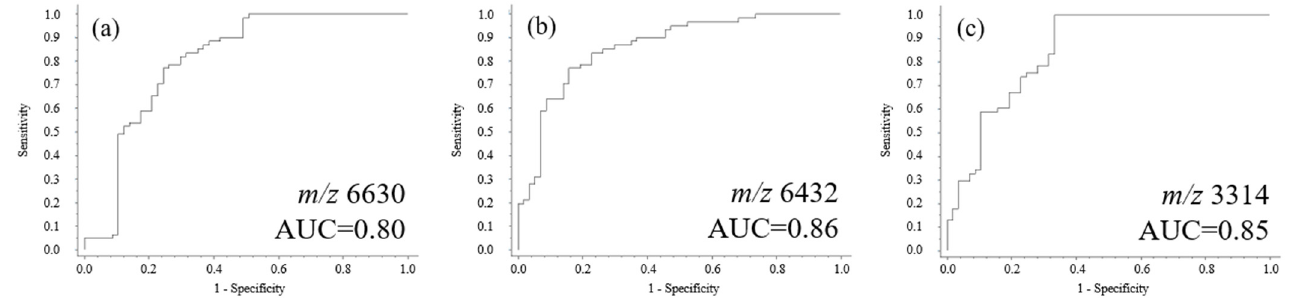
Figure 7. Representative ROC curves ( a – c ) analysis for healthy controls and MDD patients. The AUC of possible pro- tein/peptide ions ranges between 0.80 and 0.86.